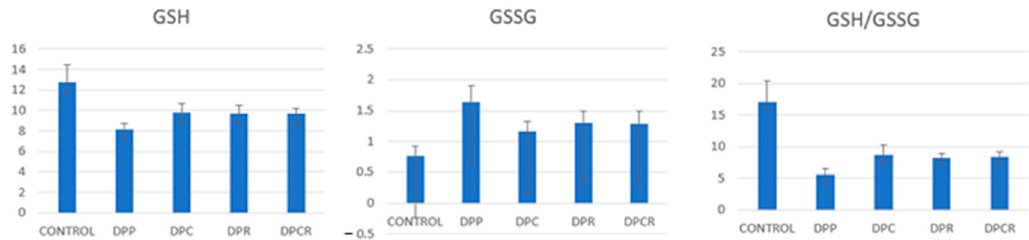
Figure 2. Mean variable evolution of glutathione (GSH) and oxidized glutathione (GSSG).